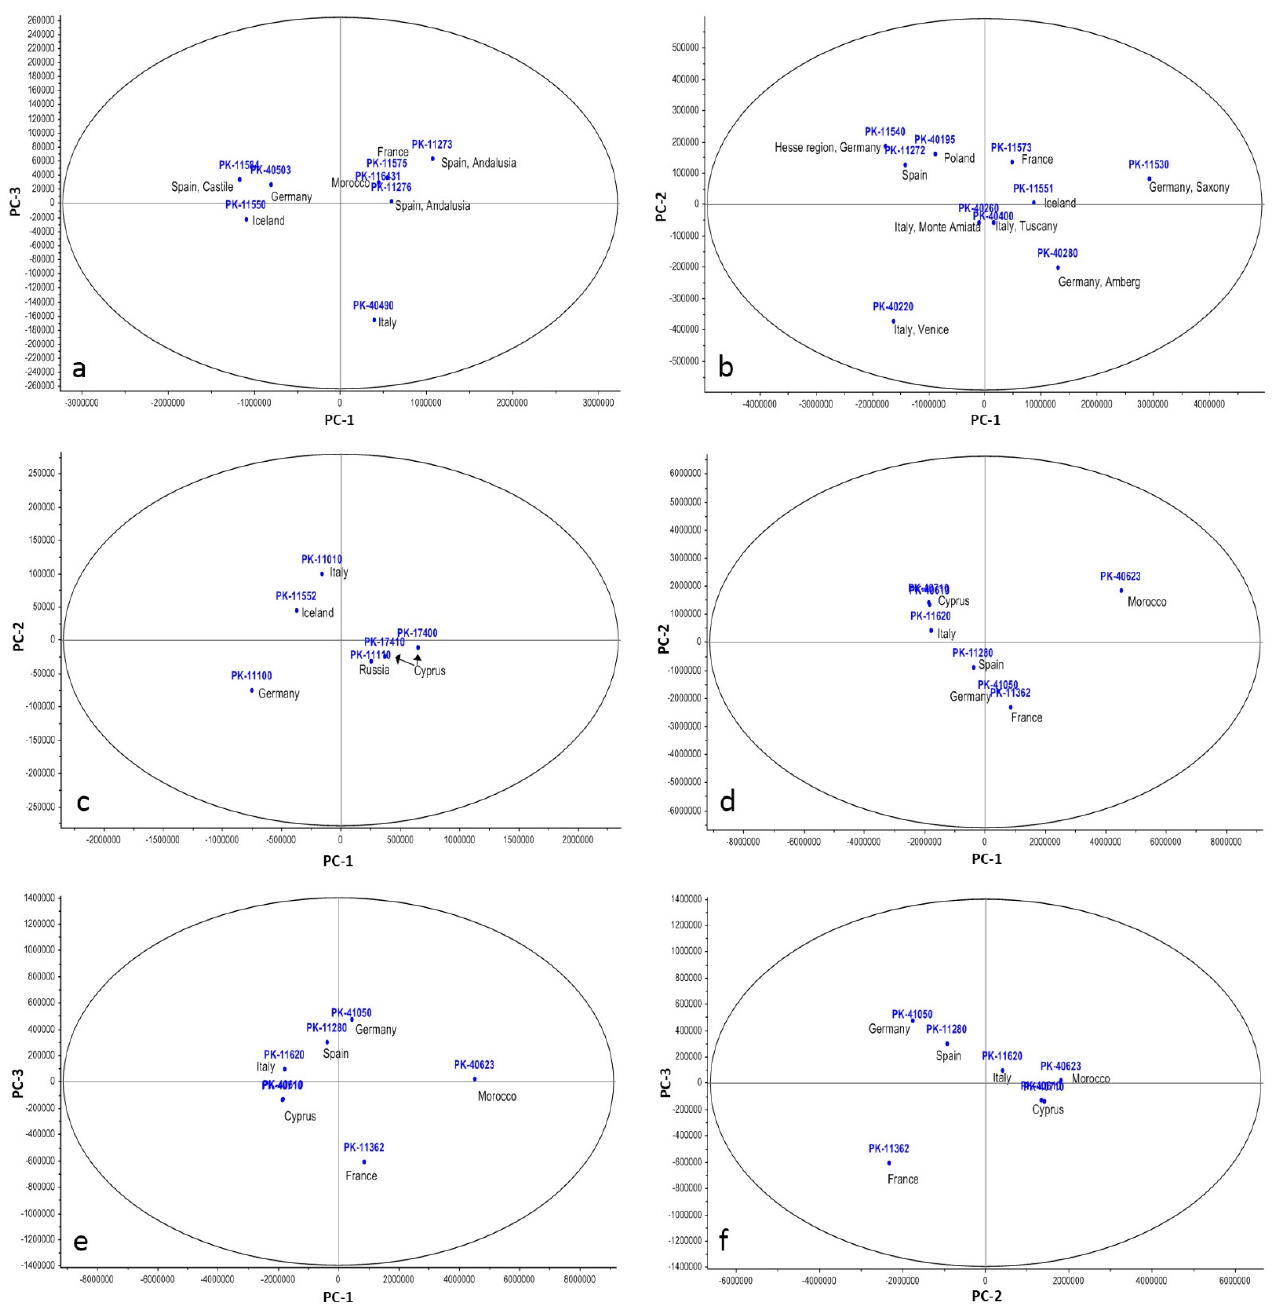
Figure 8. XRF-PCA model of: ( a ) red ochers, ( b ) yellow ochers, ( c ) green earths, ( d – f ) brown and black earths.